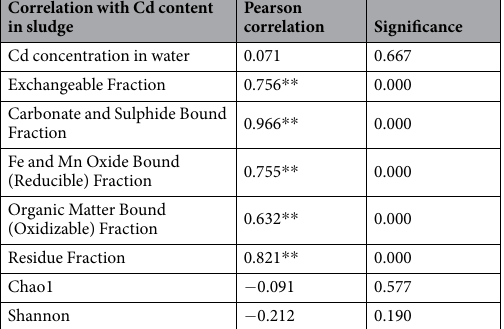
6 Scientific RepoRts | 7: 227 | DOI:10.1038/s41598-017-00280-y